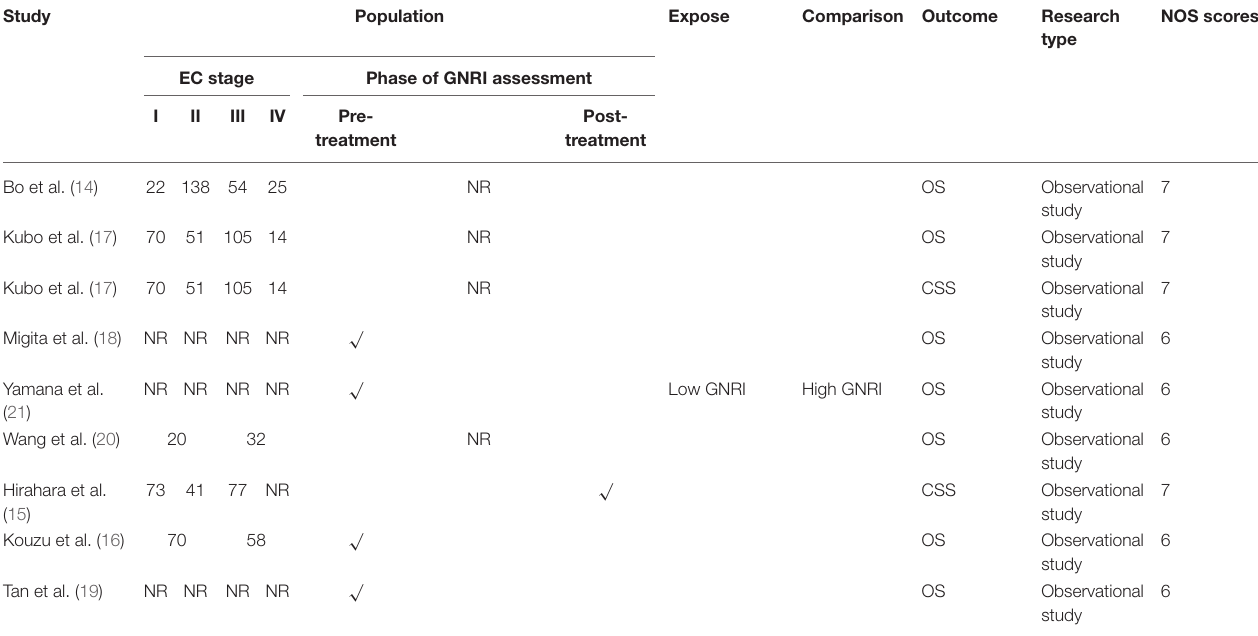
TABLE 2 | Abstract table summarizing PECO in the studies of GNRI.